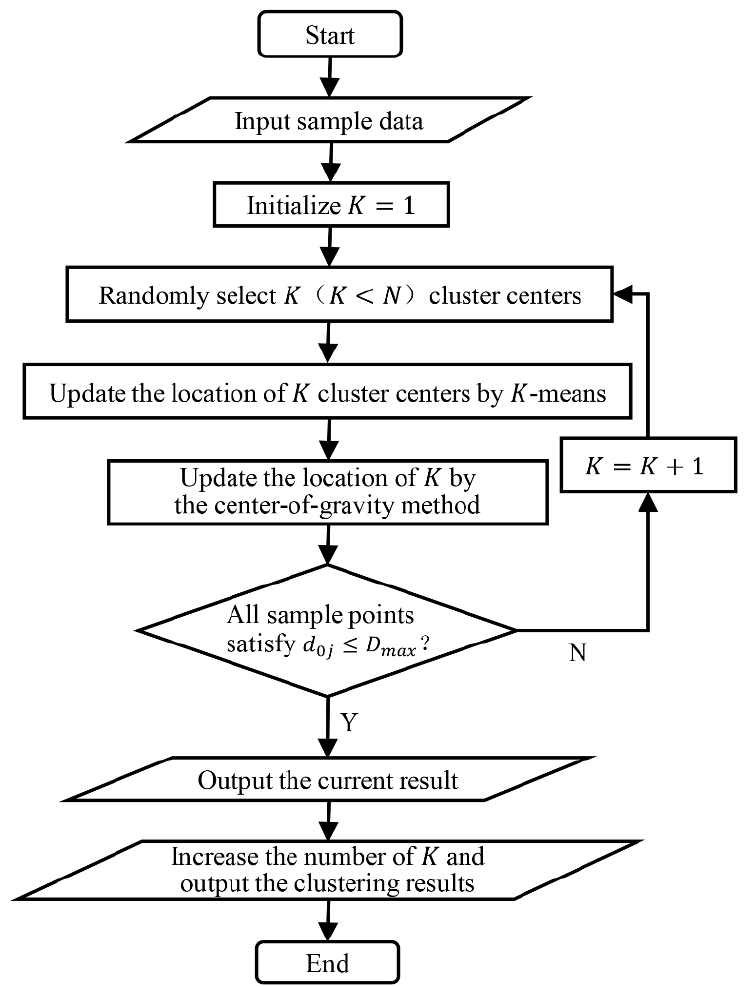
Figure 4. Improved K -means